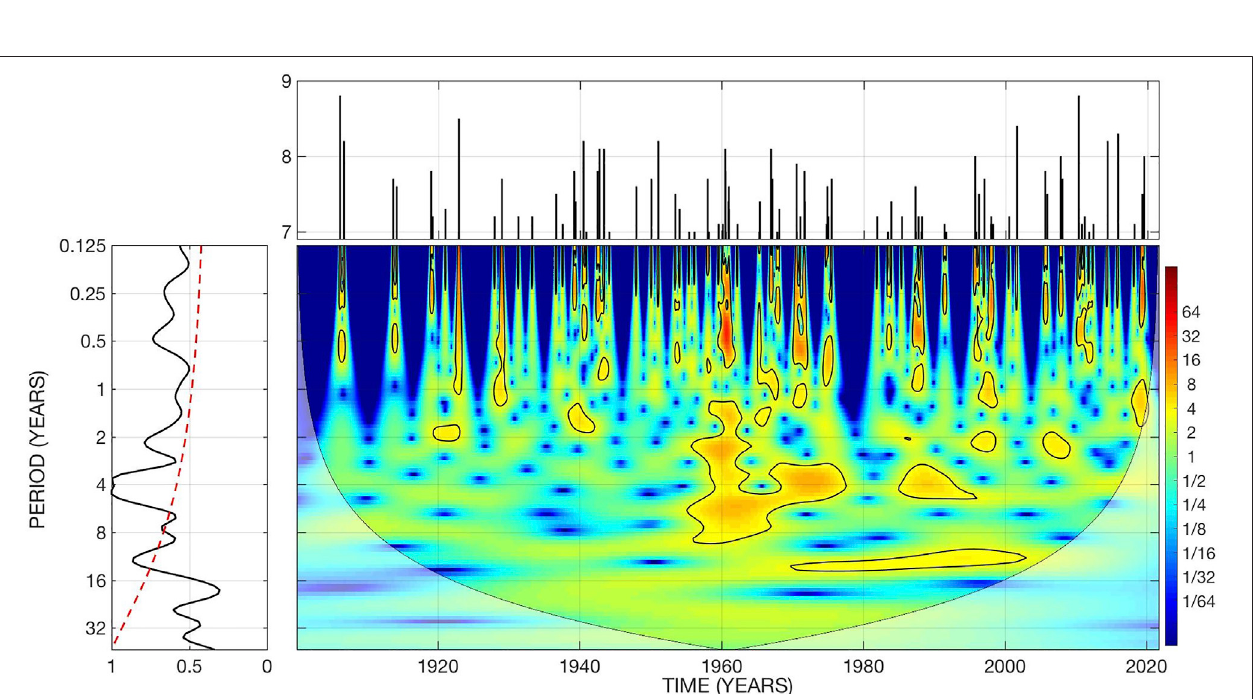
FIGURE 7 | Results of the time-frequency wavelet spectral analysis of earthquake time series record ( M ≥ 7) for the South American seismic zone between 1900 and2021.Theglobaltime-averagedwaveletperiod(leftpanel)withthereddashedlineindicatingthe95%con fi denceleveldrawnfromarednoisespectrum.TheMorlet wavelet power spectral density (MWPSD) in arbitrary units adopting the red-green-blue colour scales (central panel). The cone of in fl uence shows the possible edge effects in the MWPSD (i.e., the U-shaped curves outside of which the spectral information can be considered unreliable).